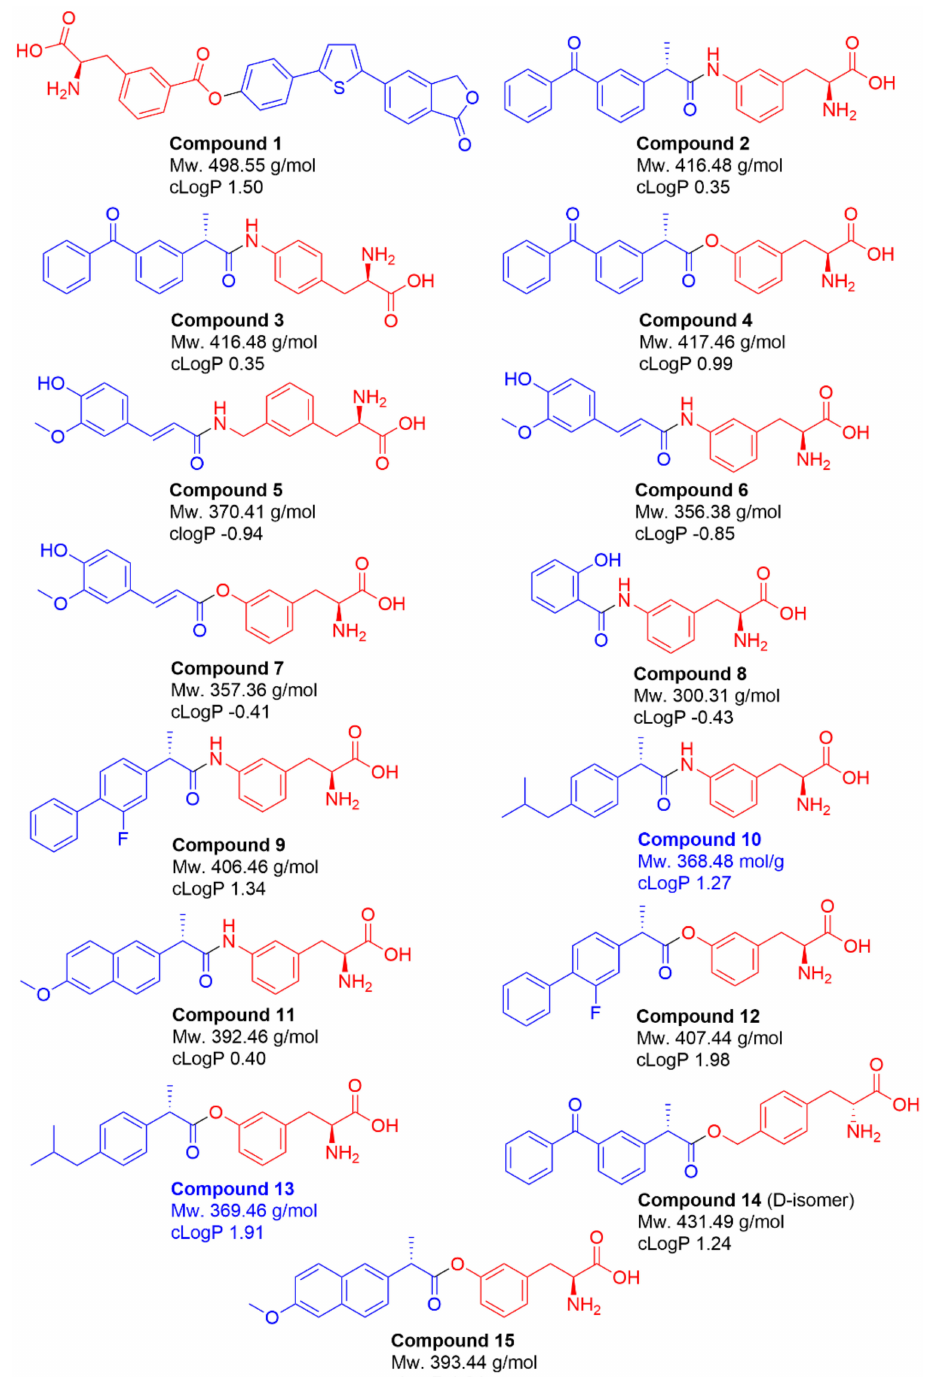
Figure 1. Chemical structures and properties of studied LAT1-utilizing compounds 1 – 15 . The parent drugs are indicated with a blue color and the promoieties with a red